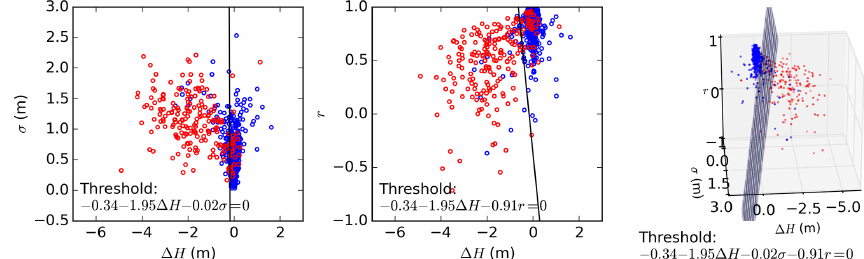
Figure 10. Classification of collapsed (red) and noncollapsed (blue) buildings using the three parameters based on SVM.